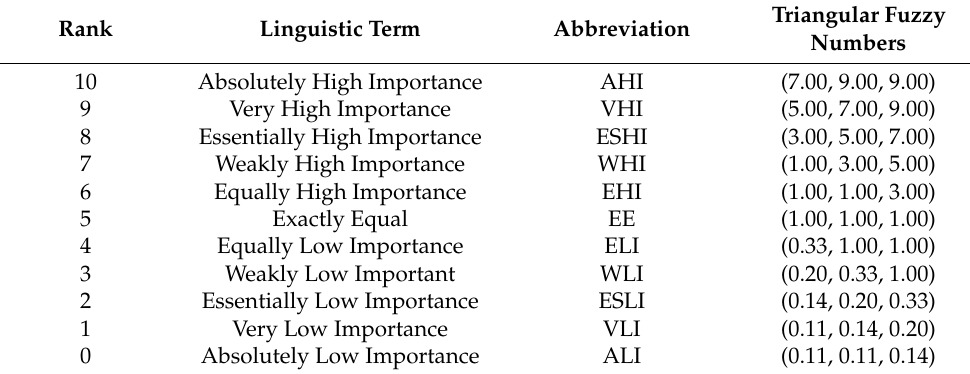
Table 3. Scale for HF-AHP